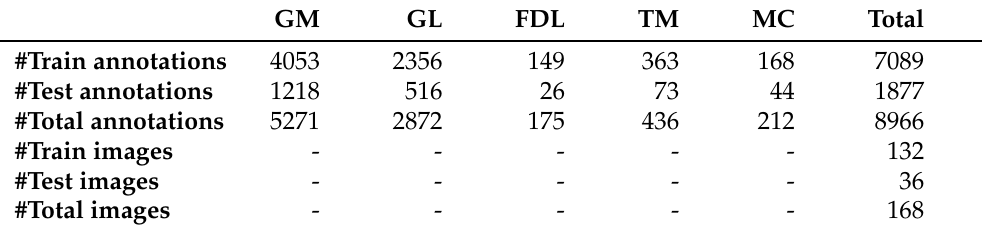
Table 1. Dataset distribution of annotations by